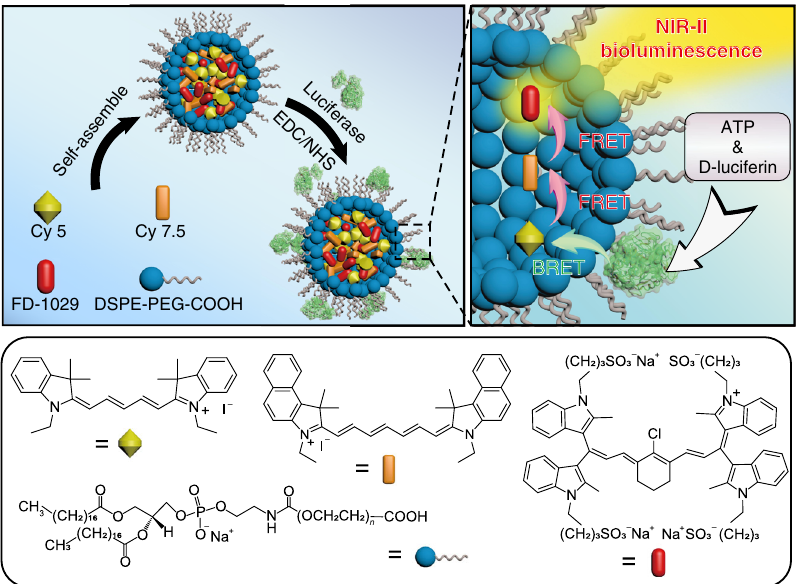
Fig. 1 Concept of NIR-II-BPs with NIR-II bioluminescence. Schematic procedures for synthesizing NIR-II-BPs and mechanism of NIR-II